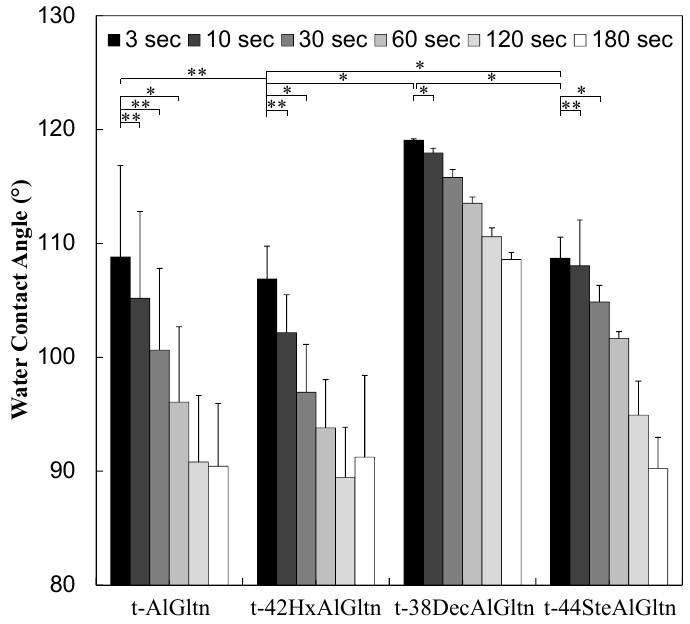
Figure 3. Surface wettability of t-hm-AlGltn films. Transition of static water contact angle on t-hm-AlGltn films (t-42HxAlGltn, t-38DecAlGltn, t-44SteAlGltn, and t-AlGltn). Data are shown as the average ± S.D. of three samples (* p < 0.05, ** p ≥